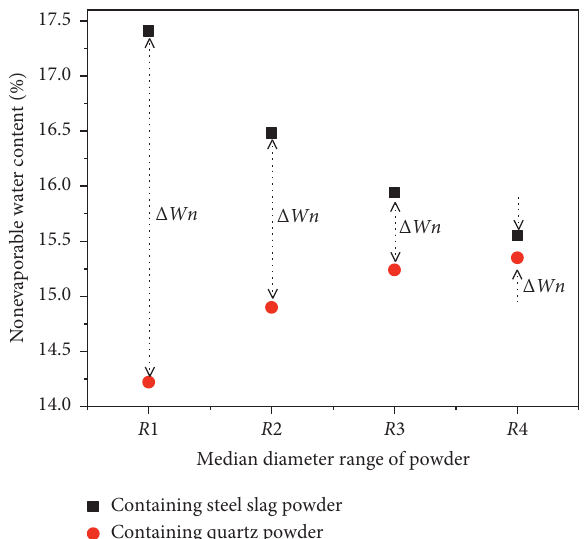
Figure 10: Nonevaporable water content of blended cement containing steel slag powder with different particle sizes.